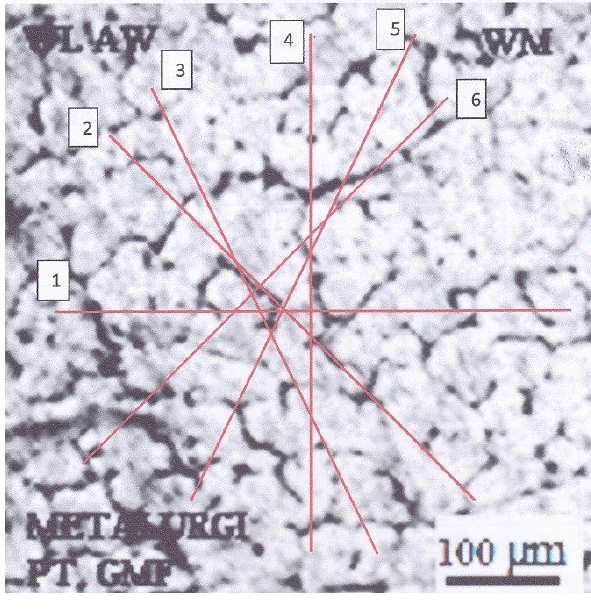
Figure 7: Conception of the linear intercept method to measure the grain size for the as-welded specimen [5].